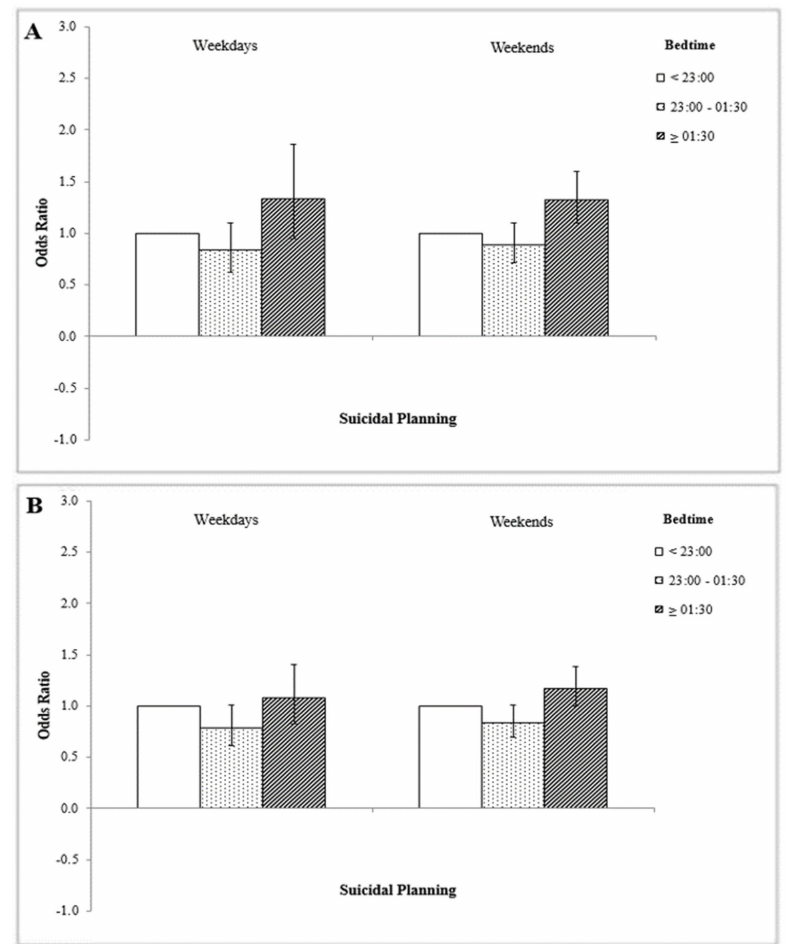
Figure 2. ( A ) Difference in suicide planning among men in terms of bedtime on weekdays and weekends. ( B ) Difference in suicide planning among women in terms of bedtime on weekdays and